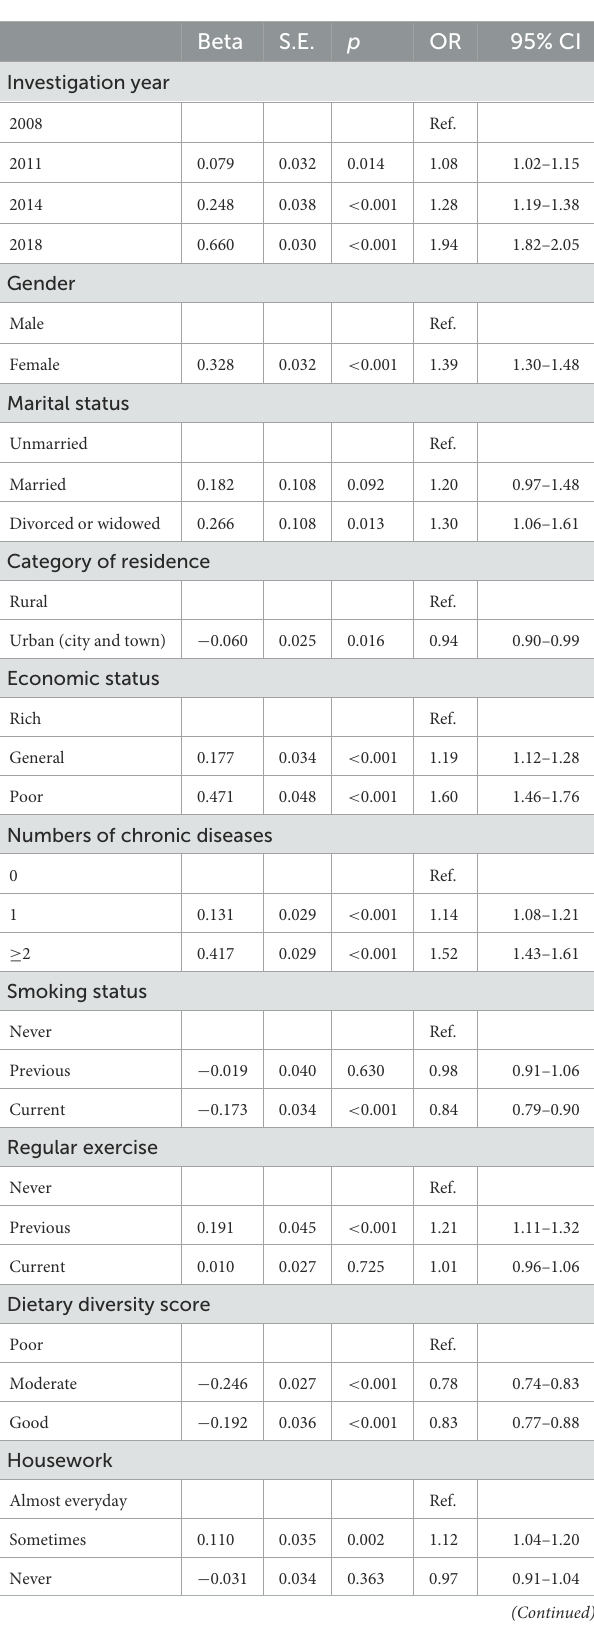
TABLE 3 Multivariate logistic regression analysis of poor sleep